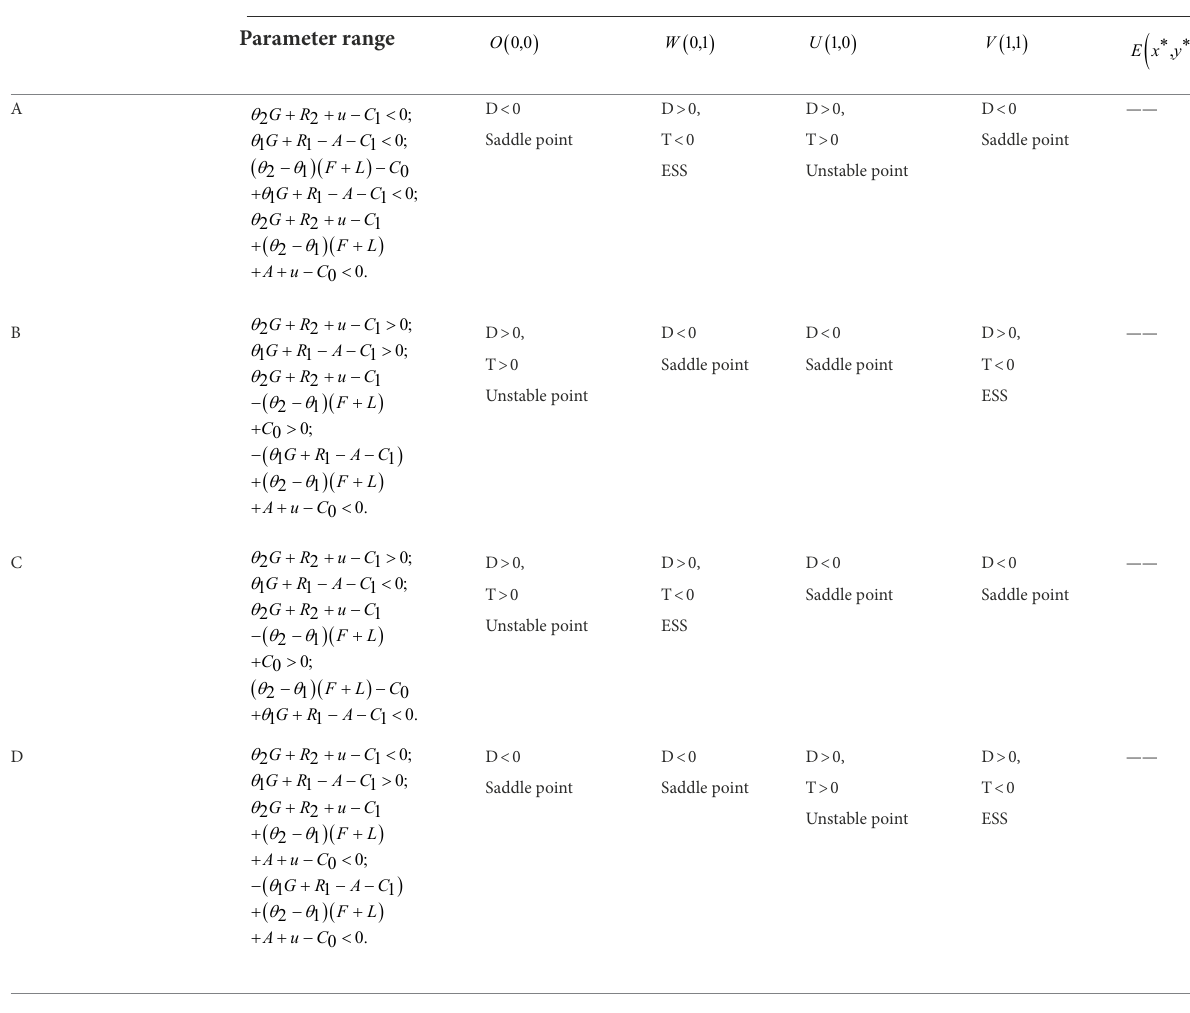
TABLE 2 Stability analysis of equilibrium points when